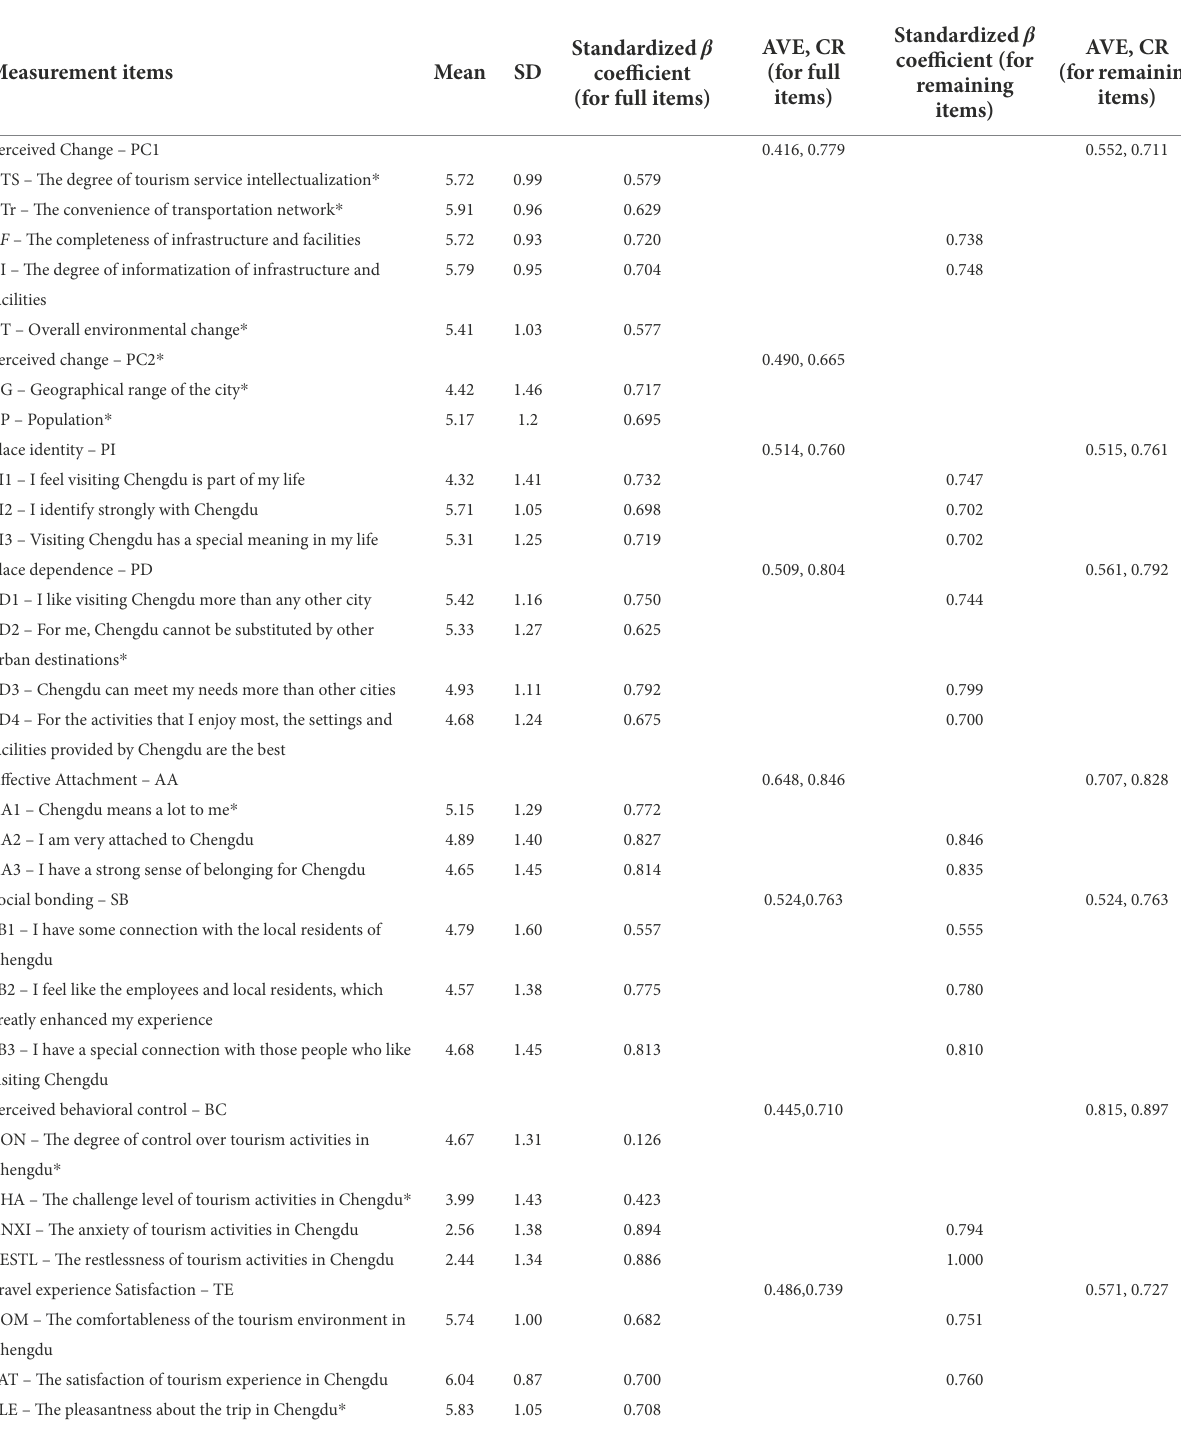
TABLE 3 Results of